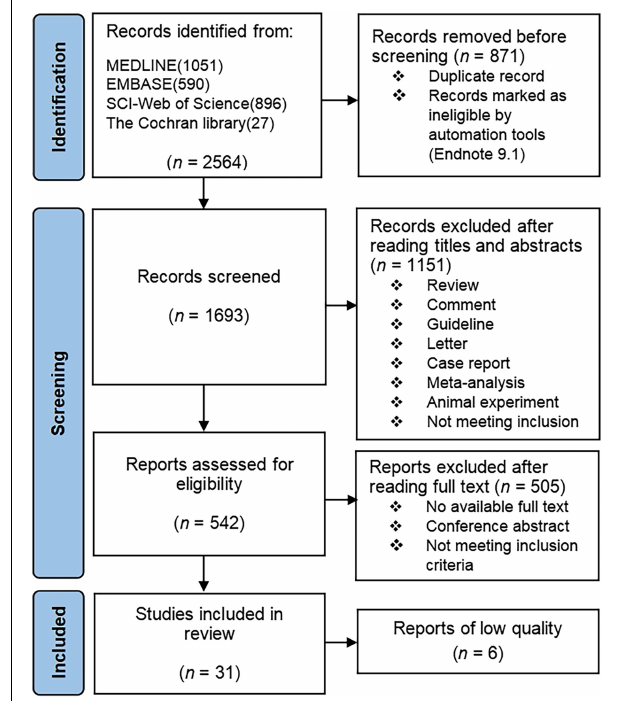
FIGURE 1 | Flow diagram of the literature search and article evaluation